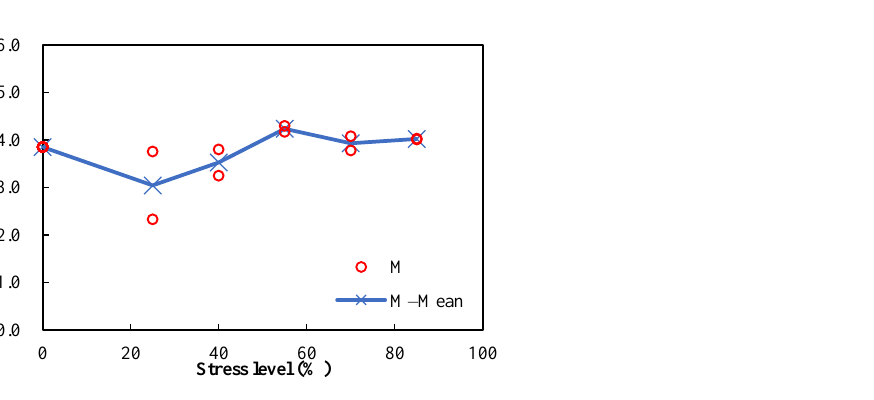
Figure 7. Porosities of damaged mortar specimens (w/c = 0.5) after different compressive stress lev- els.